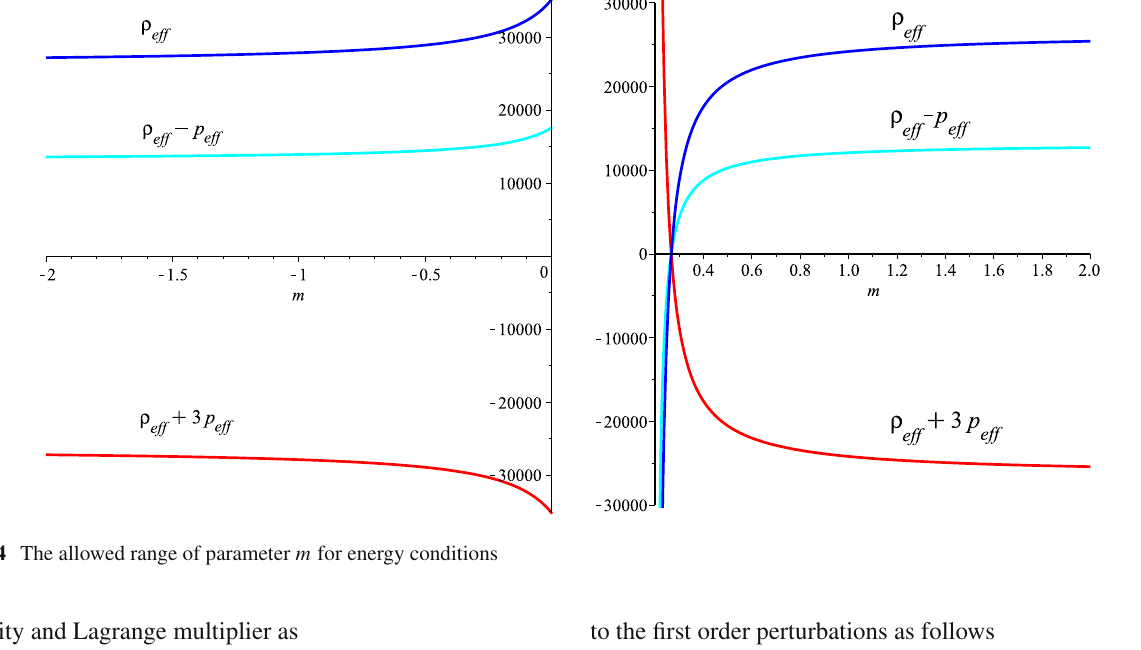
density and Lagrange multiplier